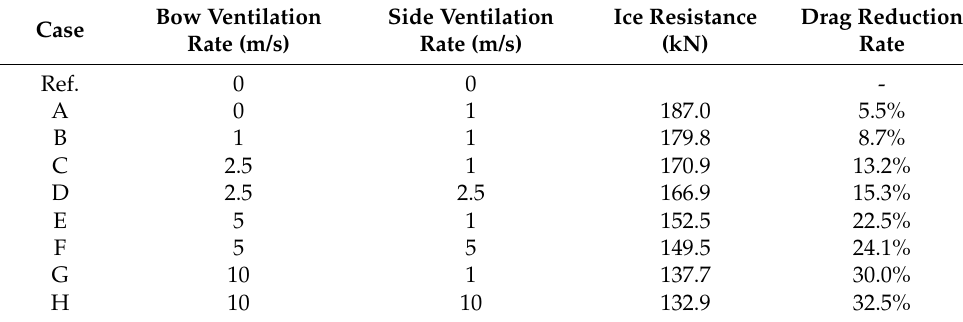
Table 5. Ice resistance under different air velocities.